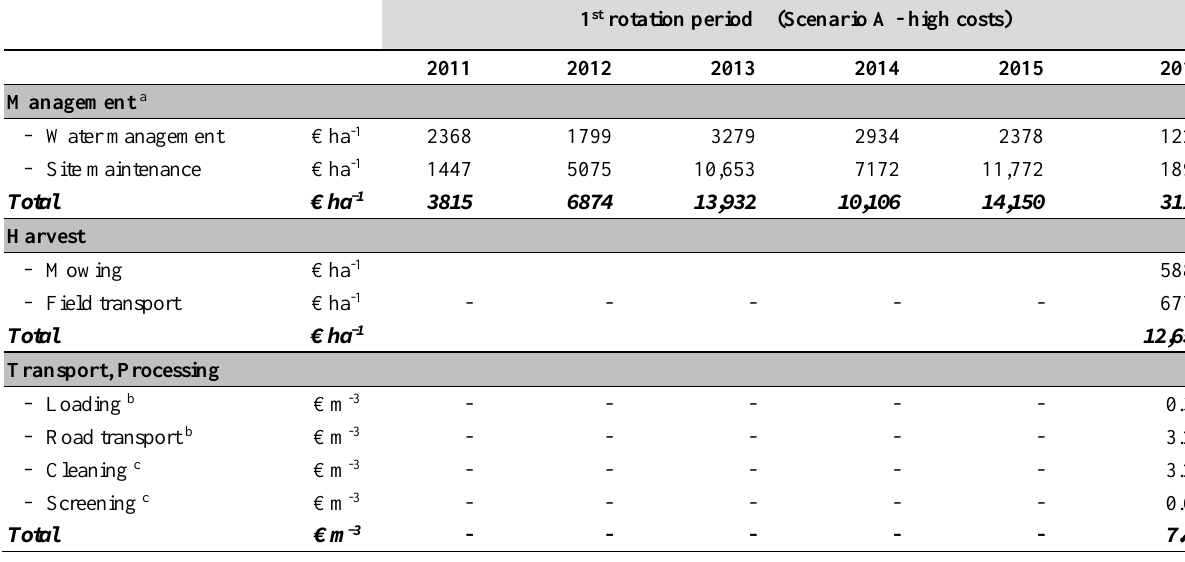
Table A2. Costs of managing and harvesting a Sphagnum farming pilot site on former bog grassland (1 st rotation period: 2011-2016), given as proportionate cost per partial net production area (€ ha -1 ) and costs of transport and processing of harvested Sphagnum biomass (€ m -3